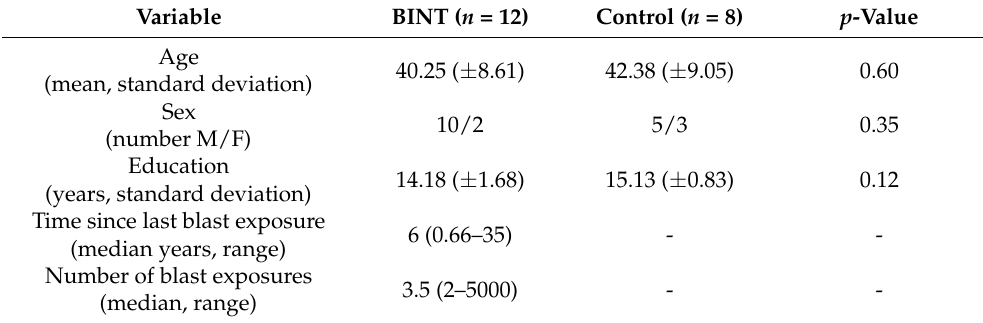
Table 1. Participant and demographic